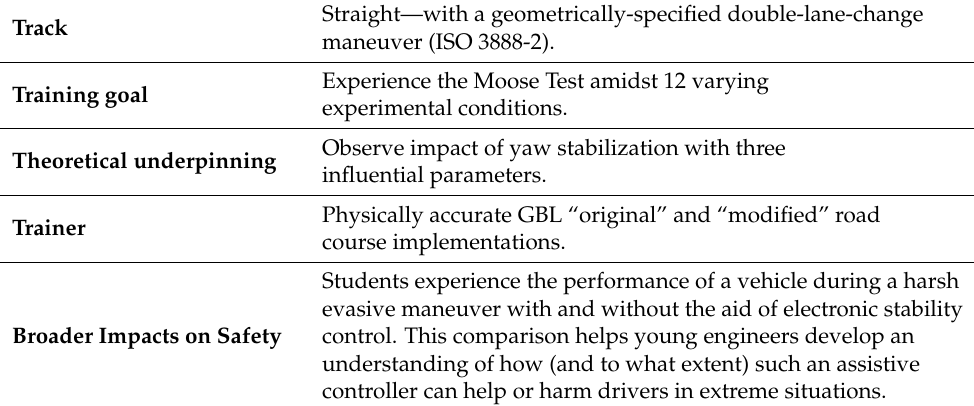
Table 3. Moose Test (experiment summary).